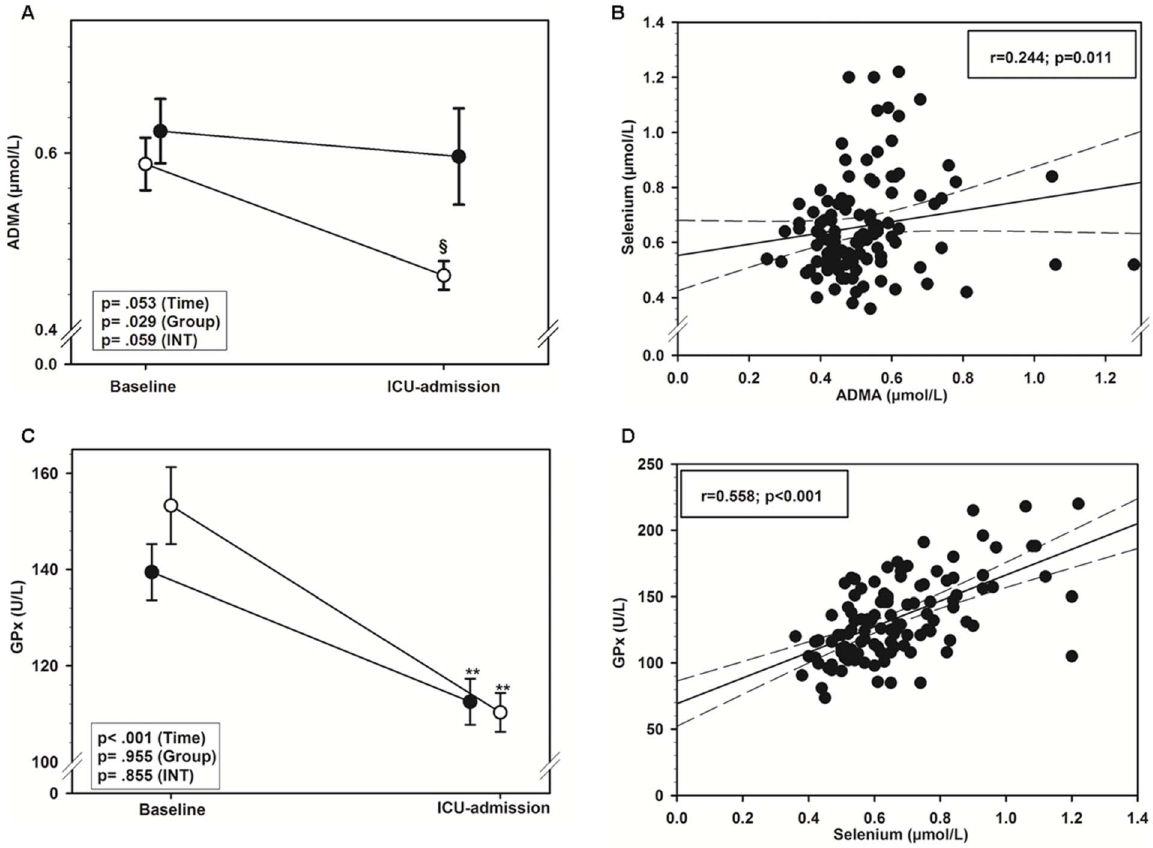
Figure 3. Perioperative time course of markers of oxidative stress and antioxidant capacity. A ) Comparison of the intraoperative decrease of ADMA levels in serum between the on-pump group (open circles) and the OPCAB-group (closed circles) at baseline (preoperative) and at ICU admission (postoperative). Data are presented as mean 6 standard deviation. 1 p , 0.05, 11 p , 0.01 versus OPCAB group, analyzed with 2-way ANOVA. B ) Correlation of whole blood selenium levels and ADMA in serum between the two groups. Data are depicted as linear regression (black line) with 95% confidence intervals (long dashed line). C ) Comparison of GPx levels between the on-pump group (open circles) and the OPCAB-group (closed circles) at baseline (preoperative) and at ICU admission (postoperative). Data are presented as mean 6 standard deviation. * p , 0.05, ** p , 0.01 versus baseline, analyzed with 2-way ANOVA. D ) Correlation of whole blood selenium and GPx content in serum between the two groups. Data are depicted as linear regression (black line) with 95% confidence intervals (long dashed line).